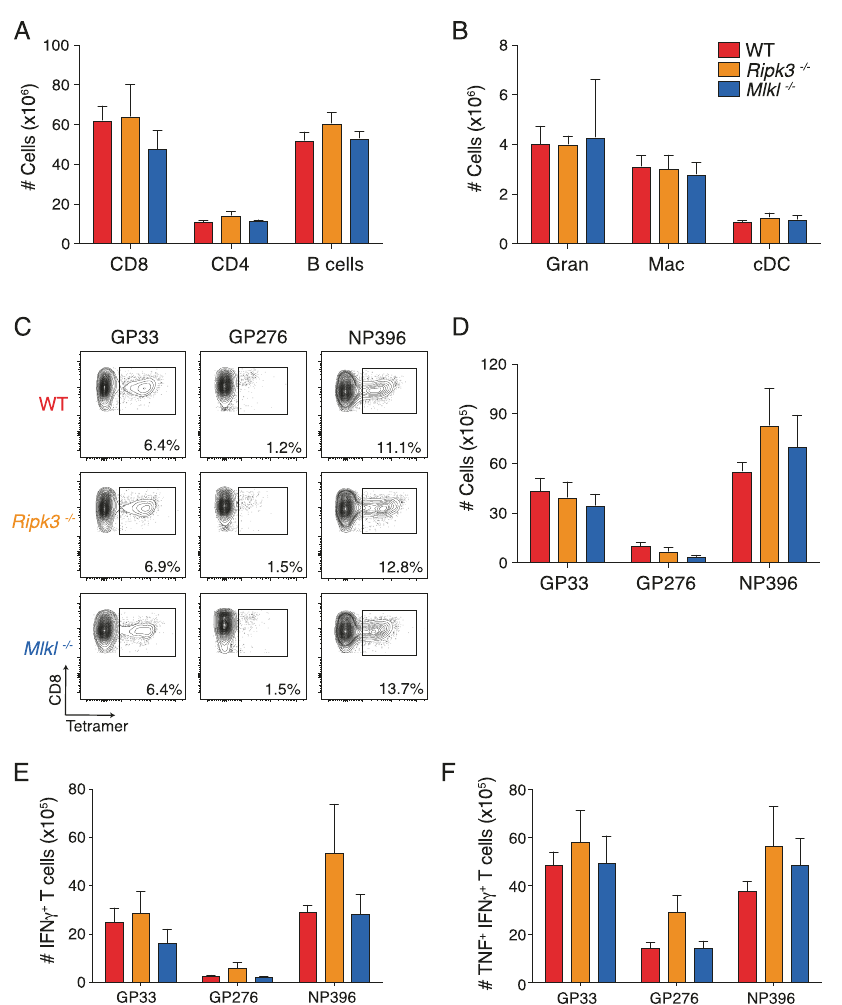
Fig. 1 Necroptosis does not contribute to the control of acute LCMV infection. Total numbers of ( A ) lymphocytes and ( B ) myeloid cells isolated from the spleens of mice with the indicated genotypes ( n = 4 mice per genotype) at 8 days post-infection with acute LCMV (Armstrong). ( C ) Representative fl ow cytometry plots showing the proportion of splenic CD8 + T cells that recognize LCMV-speci fi c epitopes. D Total numbers of CD8 + T cells, with the indicated speci fi cities, same experiment as ( C ) ( n = 4 mice per genotype). E , F Ex vivo cytokine production by LCMV-speci fi c CD8 + T cells. Total splenocytes were re-stimulated with the indicated recombinant cognate LCMV peptides. Numbers of CD8 + T cells producing the indicated cytokines ( E , F ) after restimulation ( n = 4 mice per genotype). All data were obtained